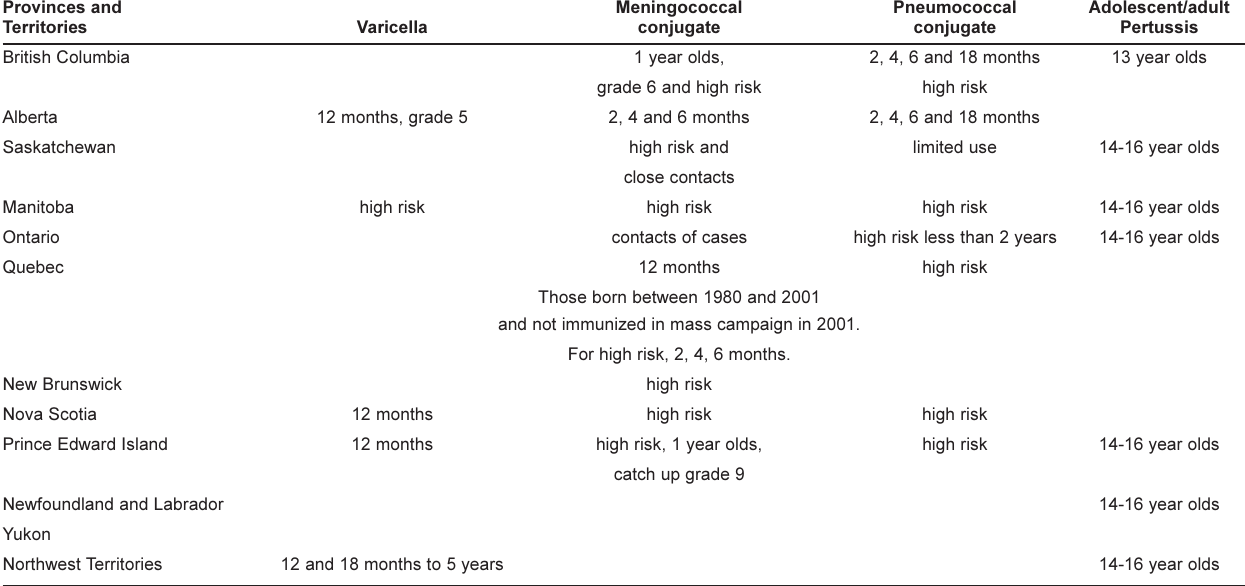
TABLE 3 Availability of ‘newer’ National Advisory Committee on Immunization recommended vaccines by province and territory in Canada Provinces